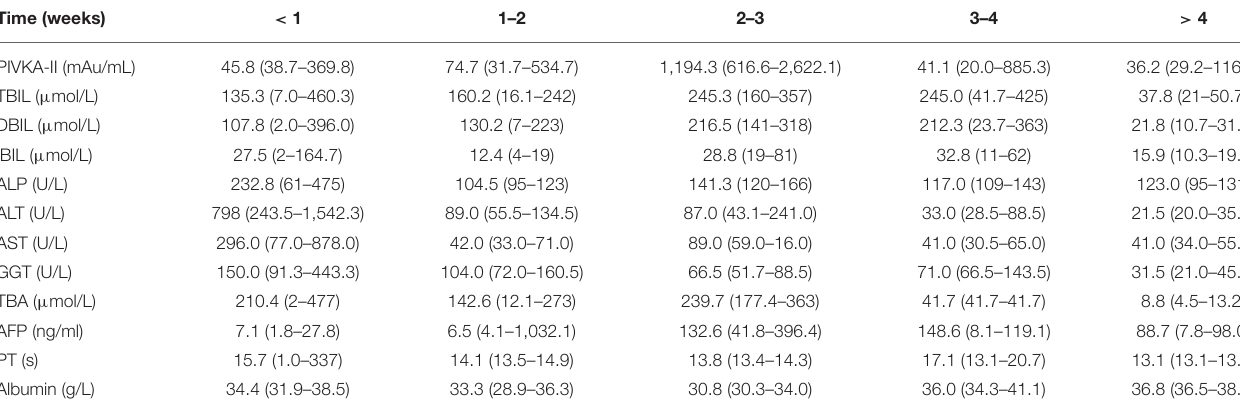
TABLE 3 | Changes in PIVKA-II and clinical biochemical indicators during hospitalization.